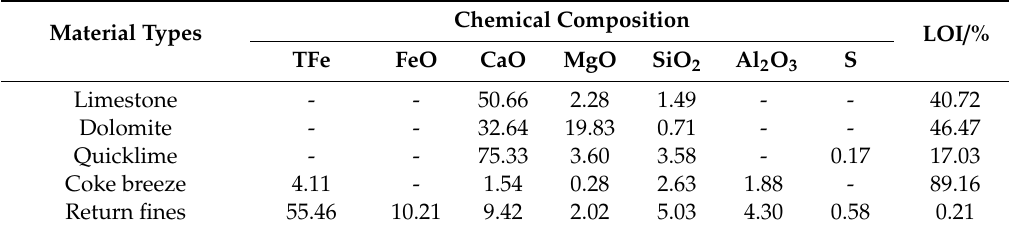
Table 2. Chemical composition of flux, fuel, and return